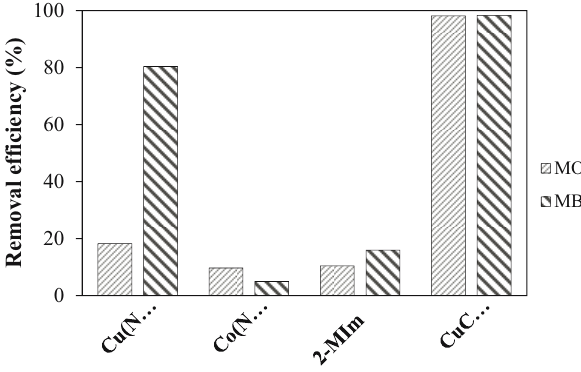
Figure 9: Comparison of MO and MB removal e ffi ciency among homogeneous catalysts and CuCo - ZIFs. MO: pH 7.0, catalyst dosage = 100 mg · L − 1 , [ H 2 O 2 ] = 0.2 mol · L − 1 , initial [ MO ] = 35 mg · L − 1 , time = 60 min, and ambient temperature. MB: pH 3.0, catalyst dosage = 50 mg · L − 1 , [ H 2 O 2 ] = 0.1 mol · L − 1 , initial [ MB ] = 40 mg · L − 1 , time = 100 min, and ambient temperature.